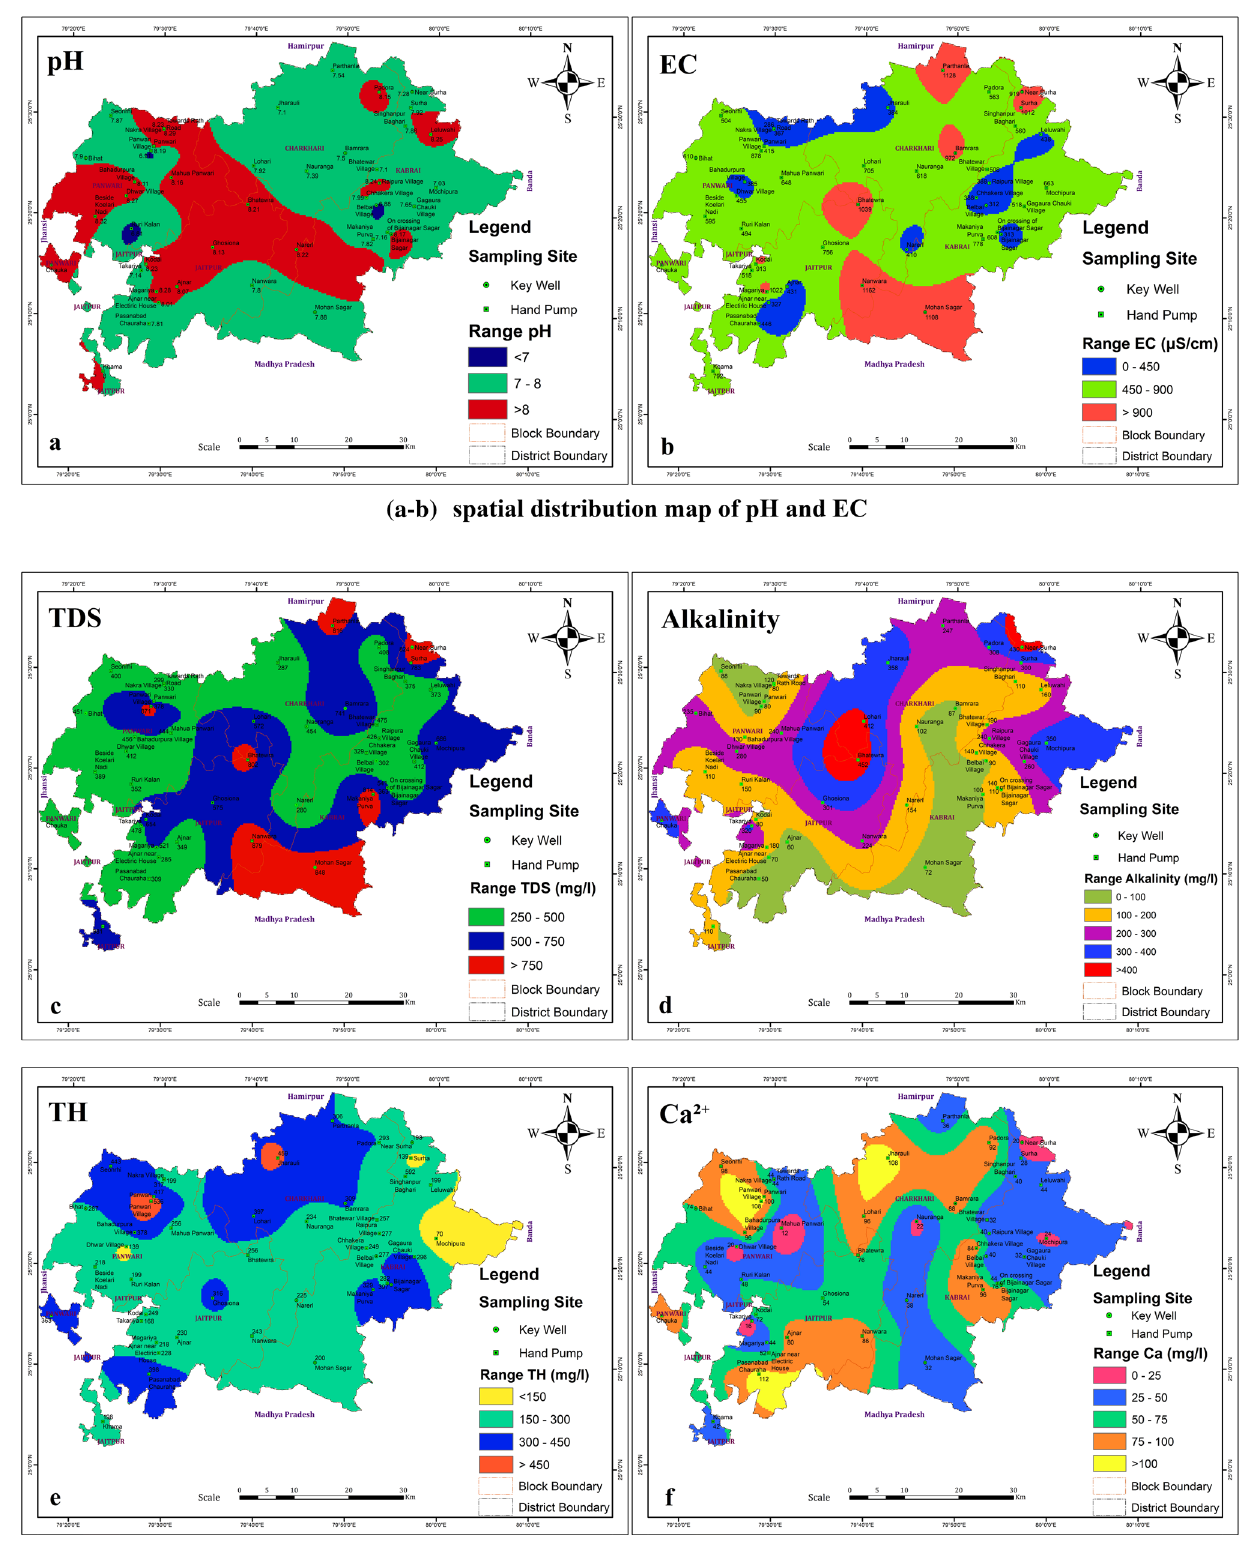
Fig. 2 a – b Spatial distribution map of pH and EC. c – h Spatial distribution map of TDS, AK, TH, Ca 2+ , Mg 2+ and Na + . i – n : spatial distribution HCO − NO − SO 2 − map of K + , 3 , 3 . o – t Spatial distribution map of Cu, Mn, Ag, Zn, Fe and 4 , Cl − , F − and